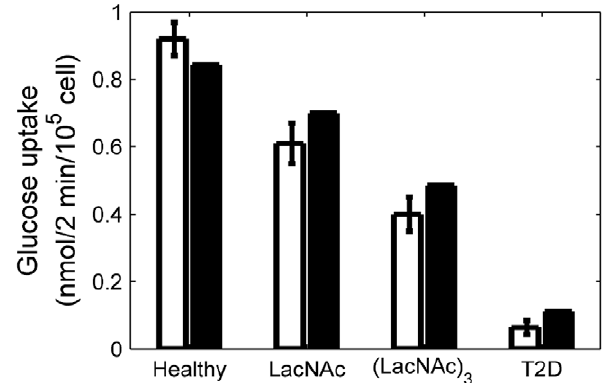
Figure 4. Glucose uptake as a function of membrane glucose transporters’ expression. Comparison between experimental data (white) (Ohtsubo et al., 2011) and model results (black) of glucose uptake at 10 mM extracellular glucose concentration, for b -cells from healthy and T2D patients, and for cells from healthy donors treated with LacNAc and (LacNAc) 3 , as indicated. Error bars represent standard deviation of the data. The percentage of GLUT-1 and GLUT-2 expression compared to healthy b -cells is also indicated in each case.